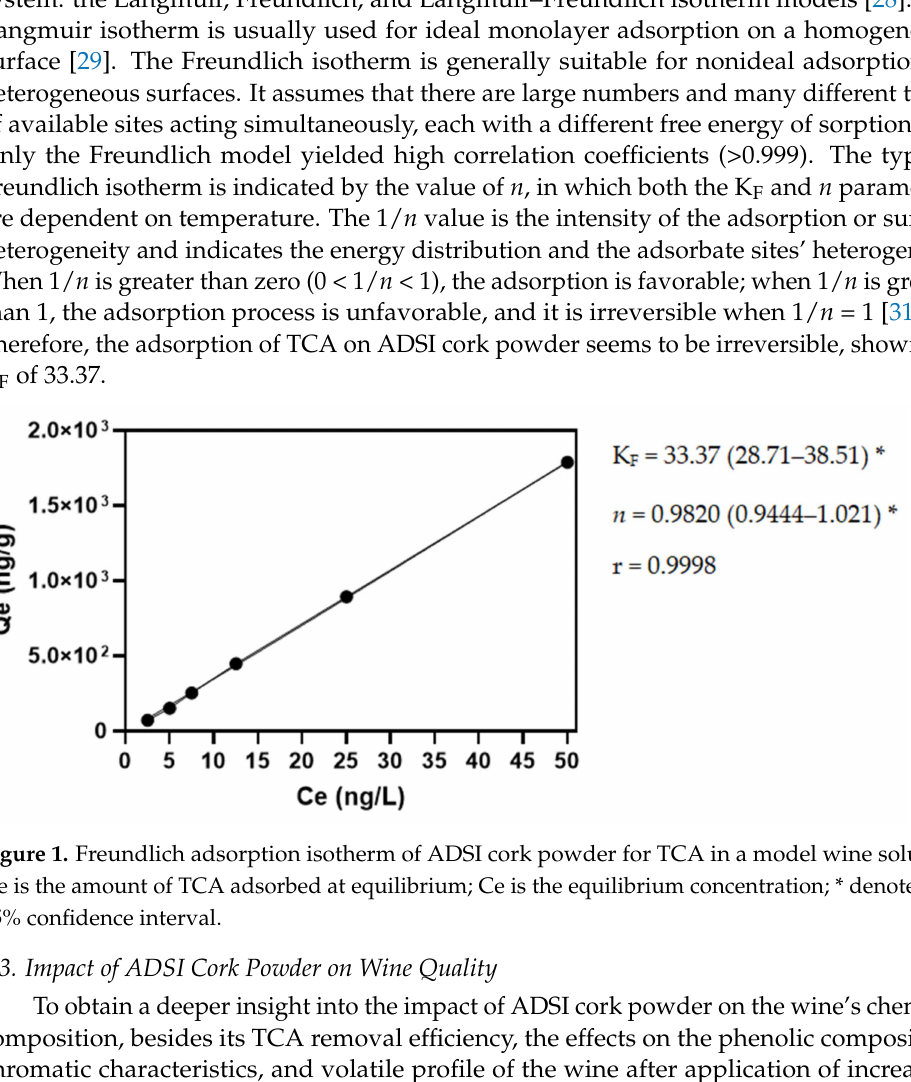
Table 2. Total phenolic compounds, color intensity, hue, and chromatic characteristics of red wines after the application of different doses of ADSI cork powder (0.10, 0.25, and 0.50 g/L). Wine TotalPhenolic Compounds(mg/L) ColorIntensitya.u. Hue